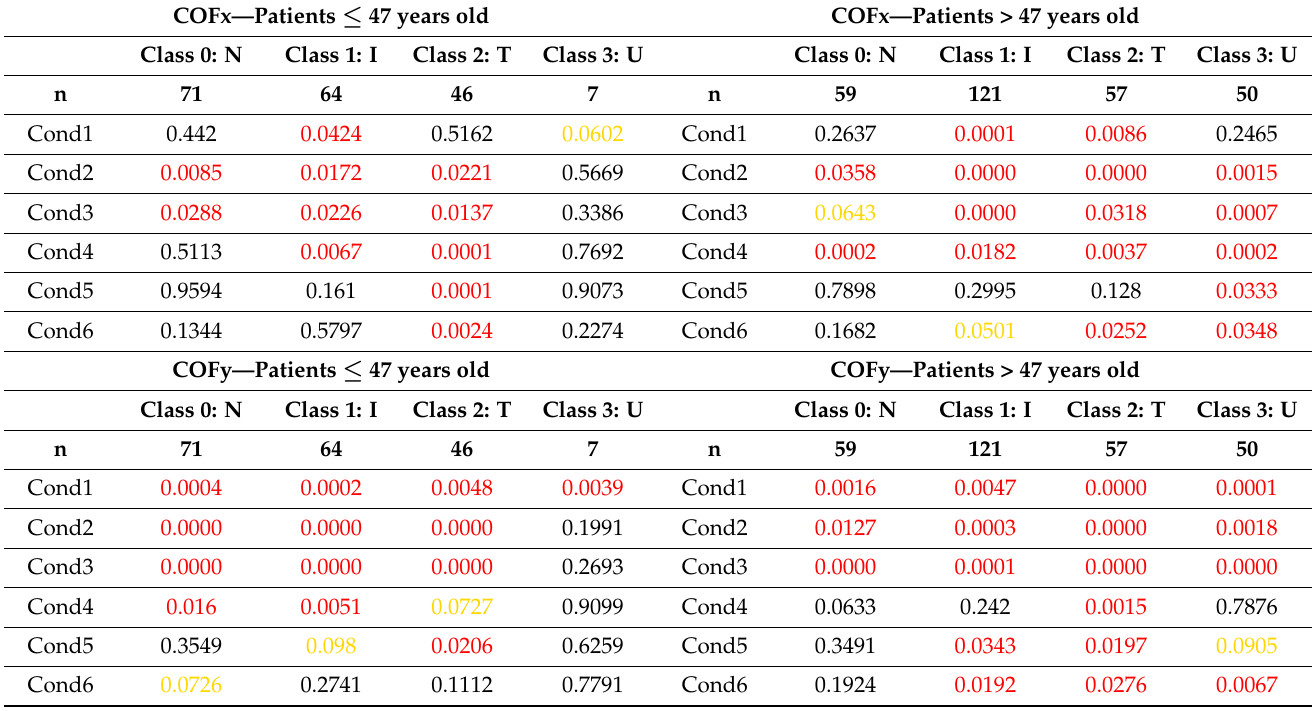
Table A1. Shapiro-Wilk test—Test of